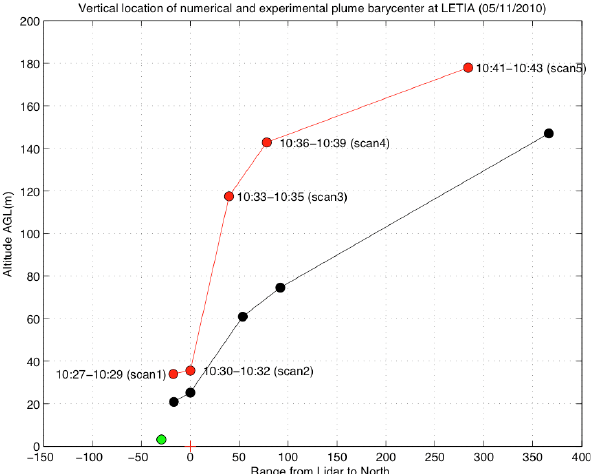
Fig. 9. Vertical locations of experimental (red circle) and simulated (black circle) barycentres; red cross and green circle symbolise lidar burning site